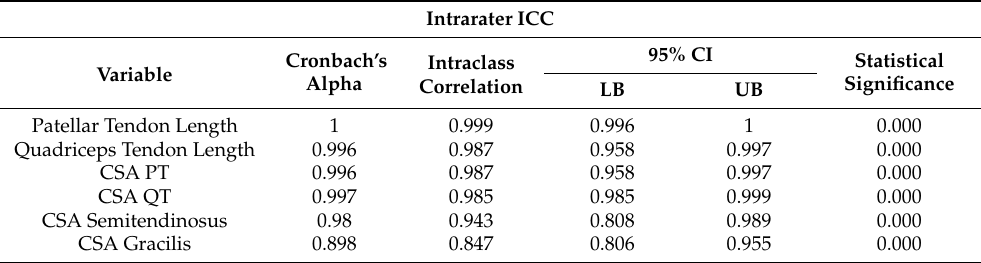
Table A2. Intrarater reliability results, n = 30. CI, confidence interval; CSA, cross-sectional area; PT, patellar tendon; QT, quadriceps tendon; UB, upper border; UL, lower